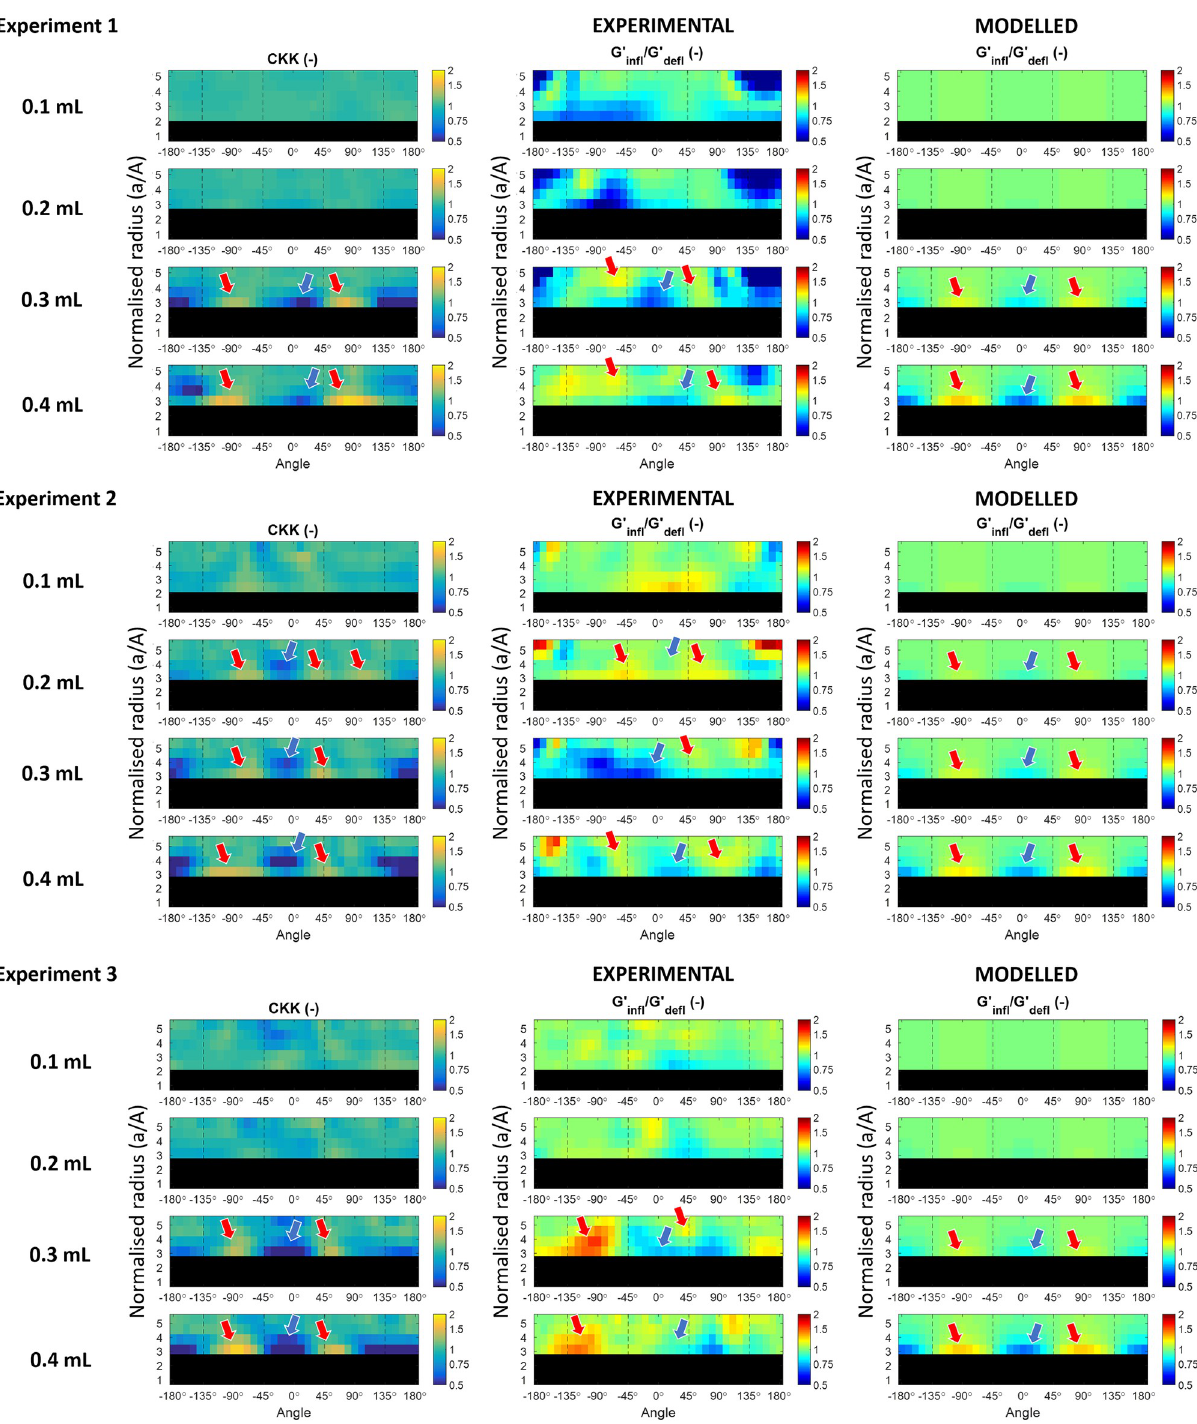
Fig 10. Measured G 0 variation supports mathematical model. Polar representation of the probed deformation (left), calculated using the local k-vector estimated from the wave images, compared with experimental (middle) and analytical (right) relative shear modulus variation at the four inflation levels investigated through three replicas of the inflation experiment. The common elements in the generated patterns are highlighted with arrows. The balloon region is blacked out.